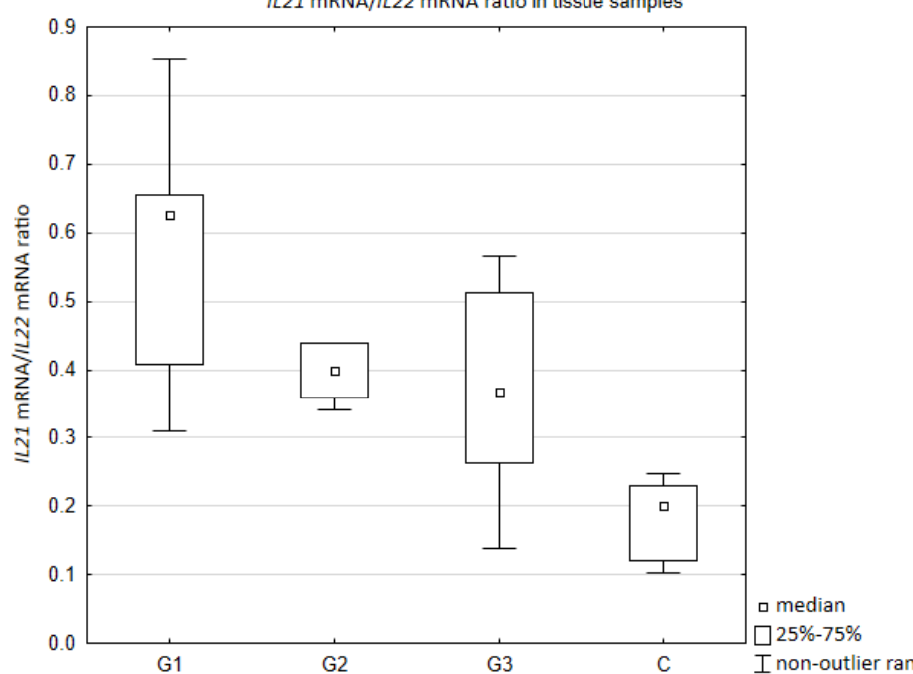
Figure 2. Il-21/IL-22 mRNA ratio in tissue samples depending on the degree of ovarian cancer differentiation G1 (well differentiated), G2 (moderately differentiated), G3 (poorly differentiated) compared to the control group (C). Ratio was calculated based on mRNA copies/µg of total RNA.